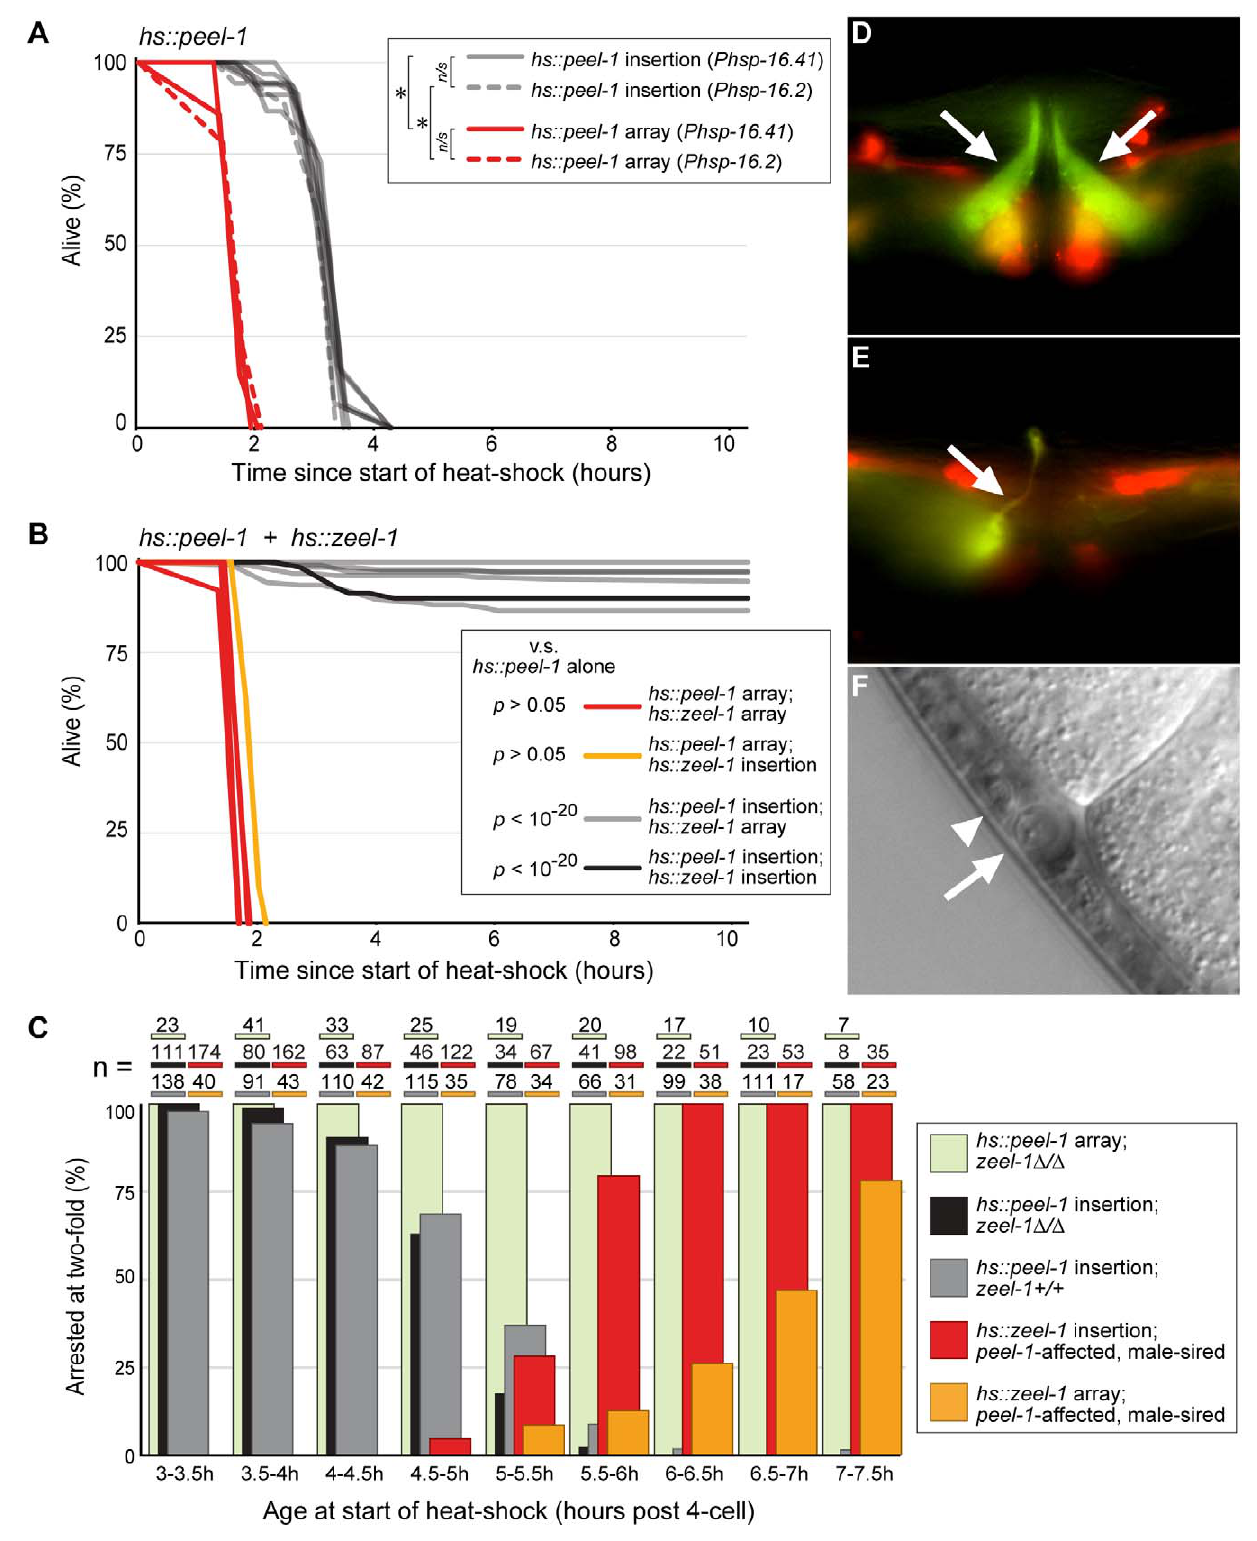
Figure 8. Ectopic expression of peel-1 and zeel-1 replicates peel-1 -mediated toxicity and zeel-1 -mediated rescue. (A) Survival curves for heat-shocked adult animals carrying extra-chromosomal arrays or single-copy genomic insertions of Phsp-16.2::peel-1 or Phsp-16.41::peel-1 . Time zero indicates the start of a 1-hour heat-shock at 34 u C. Curves represent one array and one insertion of Phsp-16.2::peel-1 and two independent arrays and seven independent insertions of Phsp-16.41::peel-1 . Log-rank tests were used to compare (i) insertions versus arrays and (ii) Phsp-16.2::peel-1 versus Phsp-16.41::peel-1 . Data for independent arrays or insertions of Phsp-16.41::peel-1 were combined prior to analysis. * p , 10 2 16 . n/s , p . 0.05. n =40–70 animals per curve. (B) One array and one insertion of Phsp-16.41::peel-1 were chosen from (A) to be tested against five independent arrays and one